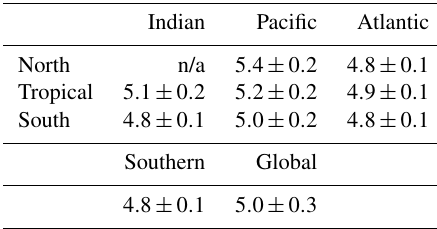
Table 1. Average EANN nitrate δ 15 N ≥ 3000m for each ocean re- gion (tropical being between 23.5 ◦ N and 23.5 ◦